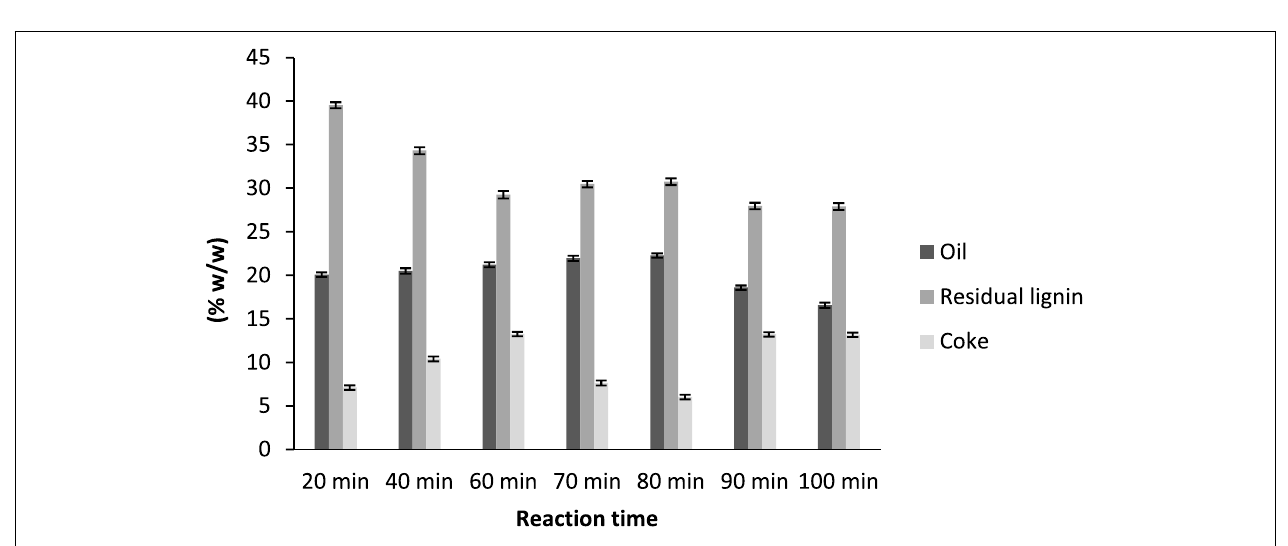
FIGURE 1 |Yields of the products obtained after base-catalyzed depolymerization of lignin at different reaction times .